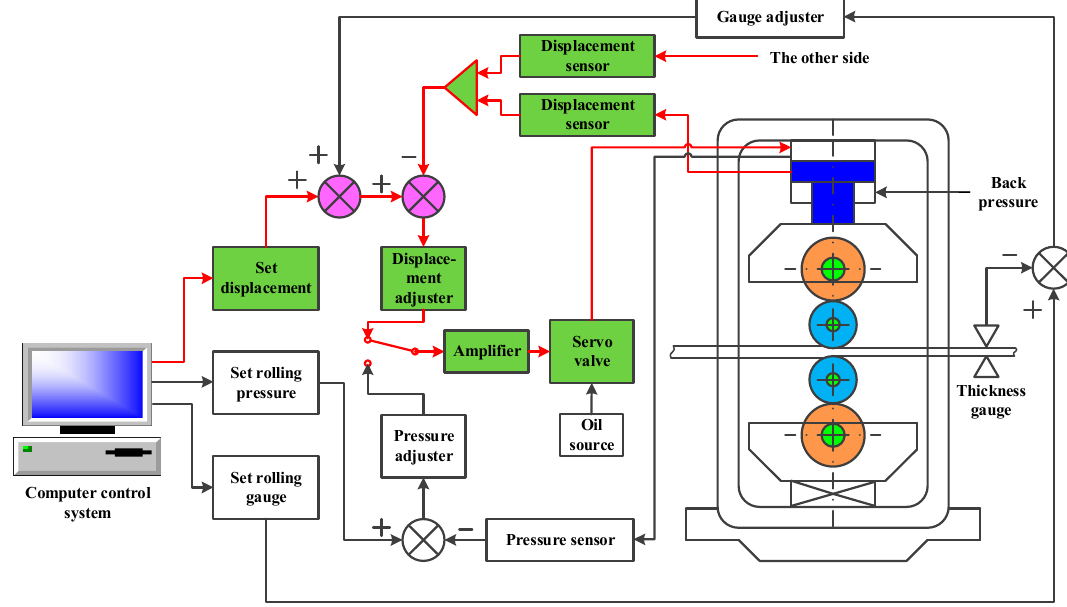
Figure 1. Function diagram of the hydraulic automatic gauge control (HAGC) system.